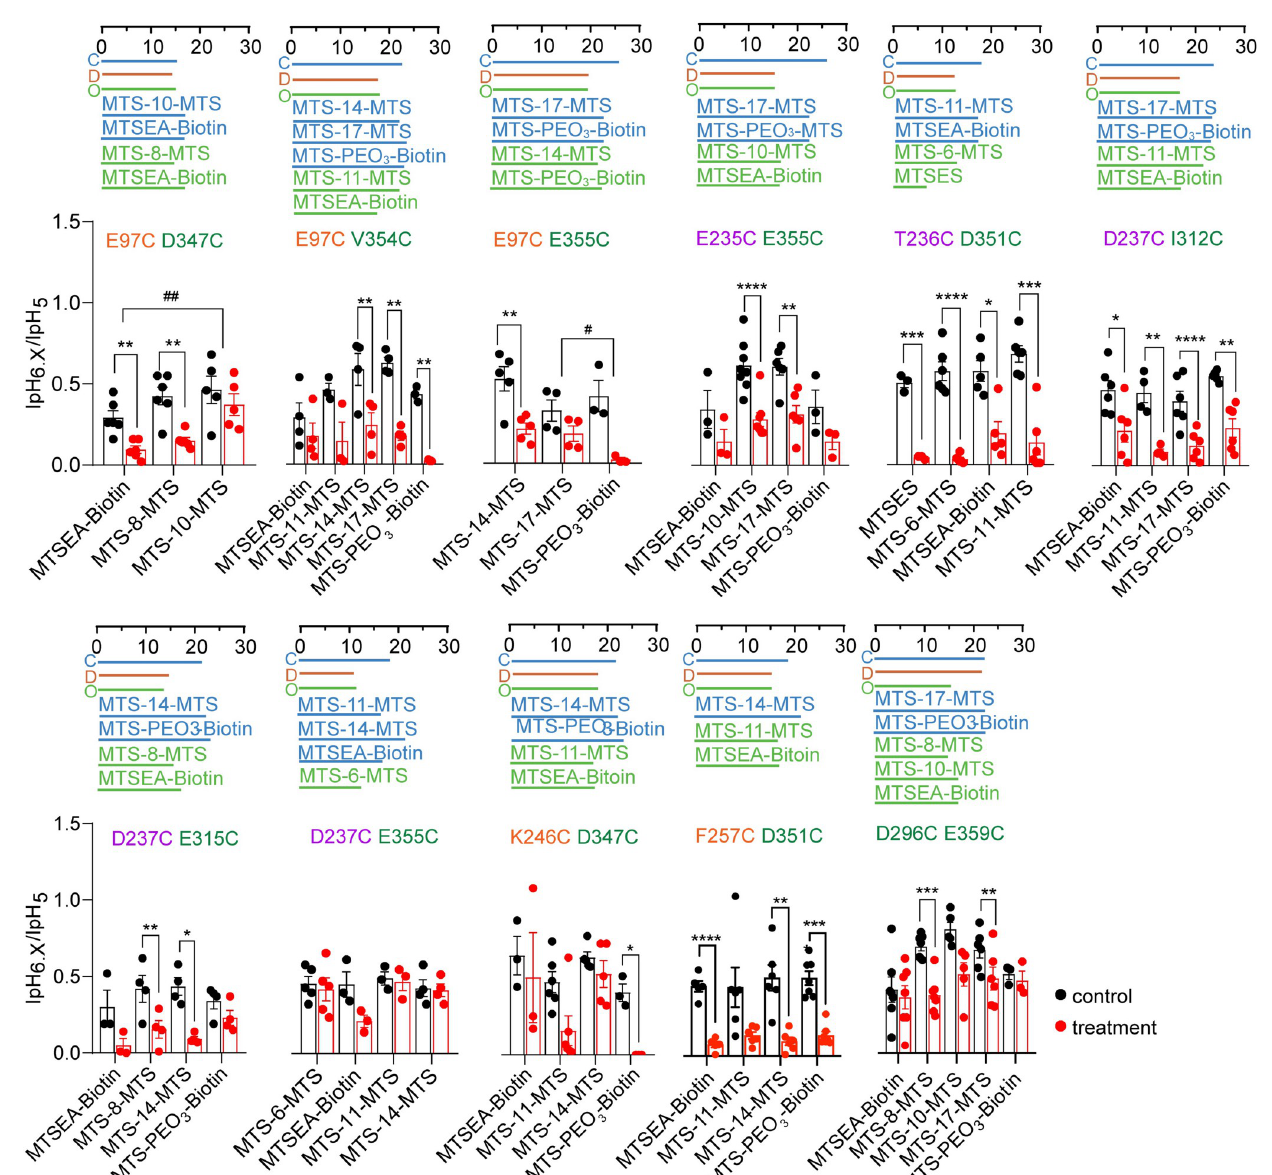
Fig 8. Effects of MTS reagents on the pH dependence of double mutants in the extracellular domain. Data were obtained from two-electrode voltage- clamp of Xenopus oocytes expressing the indicated constructs, clamped to -60mV. The IpH6.x/IpH5.0 ratio was determined in each cell before and after exposure to the MTS reagent and is indicated with black symbols for the control condition, and with red symbols for the condition after exposure to the MTS reagent. Changes in the IpH6.x/IpH5.0 ratio indicate that the MTS reagent affected the pH dependence. The pH6.x was pH6.6 for the mutant E97C-E355C, pH6.4 for E97C/V354C, E235C/E355C, D237C/E315C, E237C/E355C and D296C/E359C, pH6.2 for T236C/D351C and D237C/I312C, pH6.0 for E97C/D347C and F257C/D351C, and pH5.5 for K246C/D347C. Differences between the control and the MTS condition are indicated as � , p < 0.05; �� , p < 0.01, ��� , p < 0.001 and ���� , p < 0.0001 (paired t-test) and between cross-linkers and matching monovalent MTS reagents as #, p < 0.05; ##, p < 0.01 (Ordinary one-way ANOVA and Sidak’s post-hoc test). The meaning of the colored horizontal lines above the graphs is the same as in Fig 7. The color of the mutant label matches that of the domain in which the mutation is